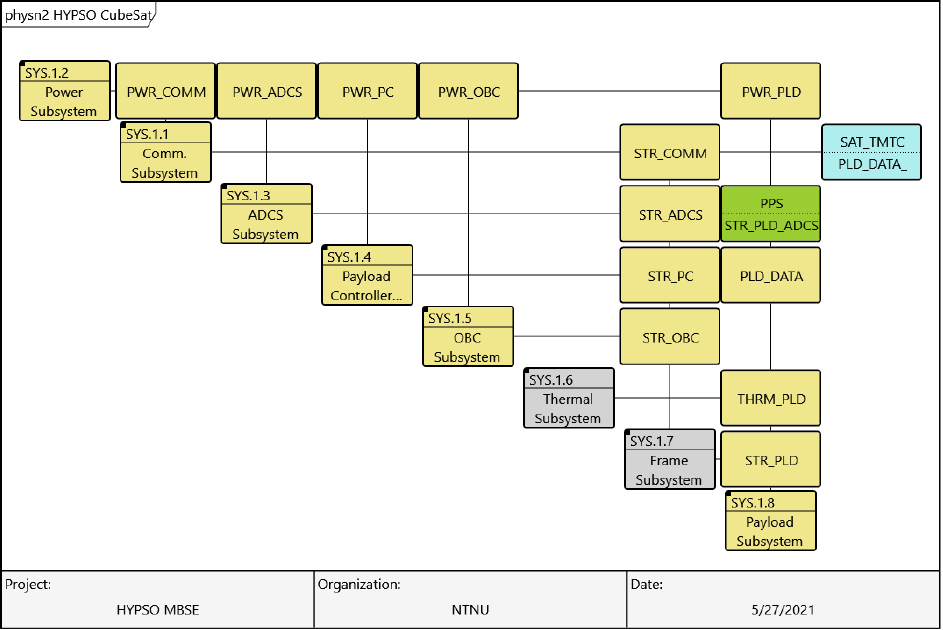
Figure 6. N2-matrix of the main interfaces for the NTNU payload subsystem (SYS.1.8.) from a logical architecture point of view. The green link between SYS.1.3 ADCS and SYS.1.8 payload is critical to ensure pointing knowledge accuracy. The yellow links are on-board the CubeSat, while the blue box is to the external subsystem (ground.) All subsystems except SYS.1.6 and SYS.1.7 (in gray) are active components and are connected via the CAN-bus. STR means Structural/mechanical support; PWR means Power interface; PLD means Payload; DT means Data; TMTC means Telemetry/Telecommand; THRM means Thermal interface; COMM means Communication. Diagram made using